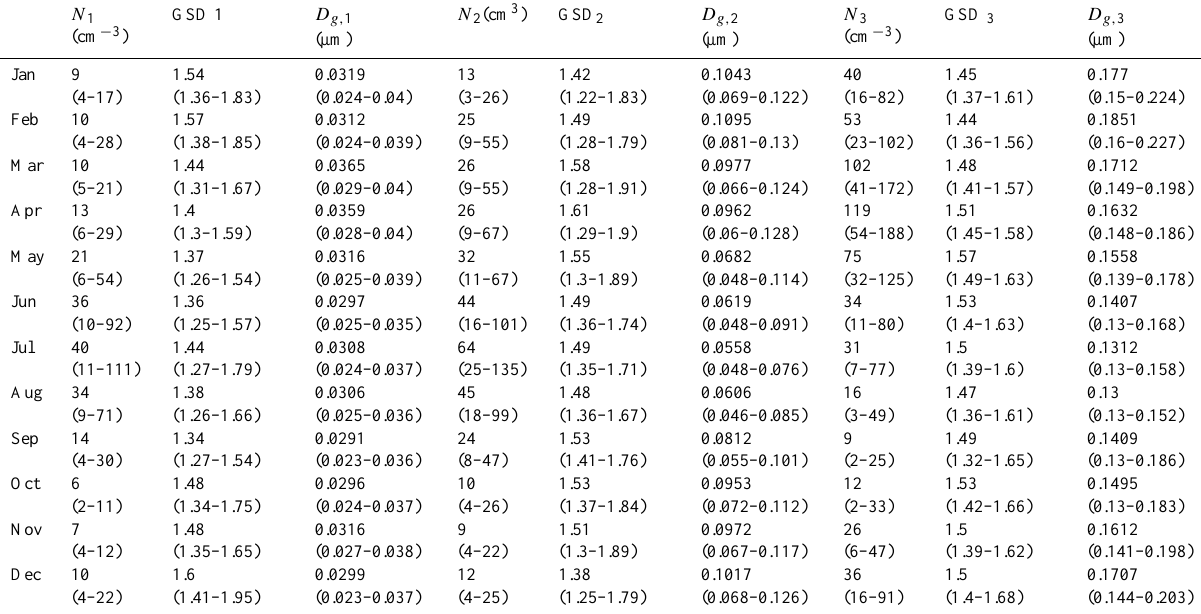
Table A1. Modal parameters and their corresponding 25–75th percentile ranges for the period of March 2000–December 2010. The lognor- mal fitting is based on daily average data for the selected time period. Given are the median of modal number concentration ( N , cm − 3 ) , modal geometrical standard deviation (GSD) and modal geometrical mean diameter ( D g , µm) for modes